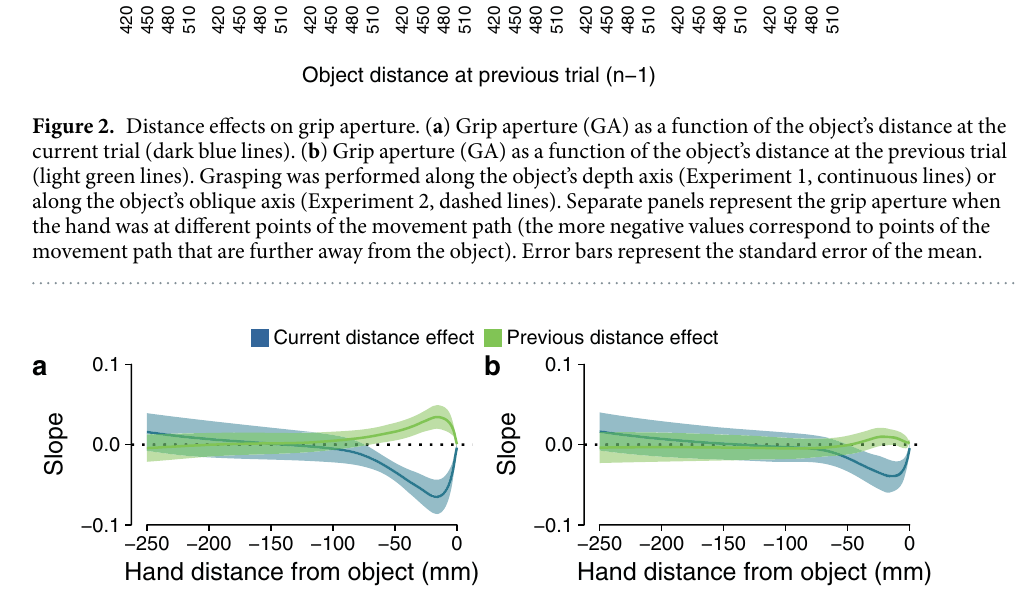
Figure 3. Current and previous distance effects on the grip aperture. Slope profiles representing the current distance effect (dark blue line) and the previous distance effect (light green line) on the grip aperture along the movement path when grasping along the depth axis ( a ) and along the oblique axis ( b ). The bands represent the 95% confidence interval of the slope